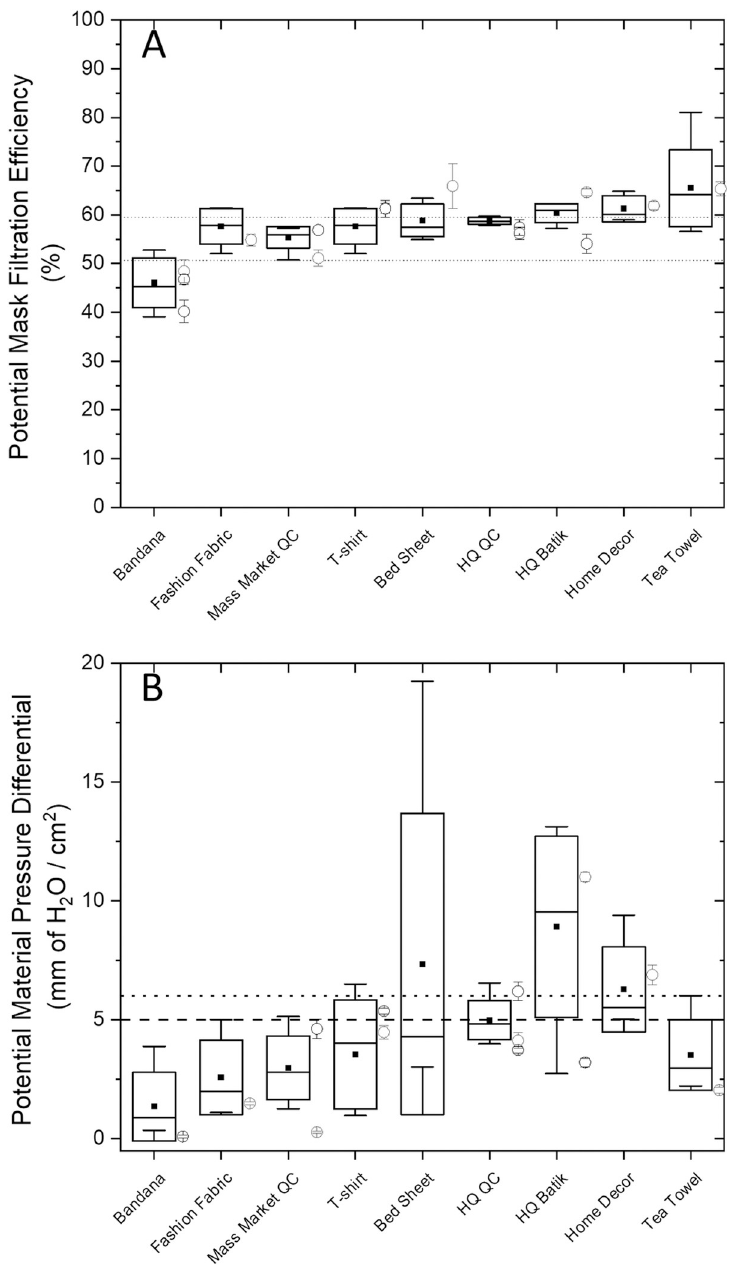
Fig 5. Model estimated mask performance across consumer fabric categories ( Graphic A ). Box and whisker plots present the median (box center horizonal line), mean ( ■ ), standard deviation (upper and lower box edges) and range (whiskers) of model predicted mask filtration performance across each fabric category. Symbols ( � ) present mean ± standard error of measured mask fitted filtration efficiency determined for each tested fabric masks from each category. Horizontal dashed lines present the range of measured mask filtration efficiencies for the L1 medical mask . Graphic B . Model estimated breathability performance across consumer categories. Graphic legend descriptors similar to those described for graphic A. Dashed horizontal line is the Level 1 Medical Mask ASTM guideline value, dotted line is the Level 3 Medical Mask ASTM guideline value.